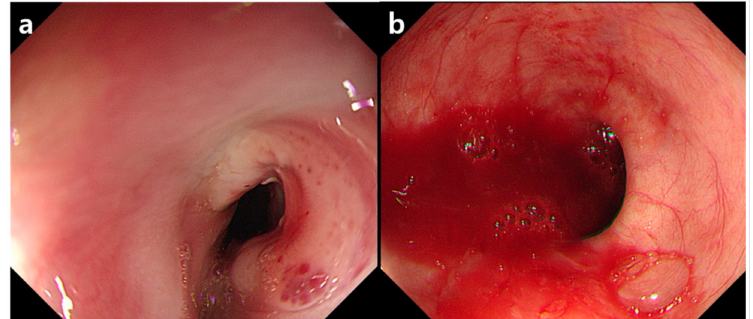
Figure 3. ( a ) Endoscopy on the first day showing a mass like lesion with an ulcer and red pigmen- tation in the upper esophagus. Active bleeding focus was not found. ( b ) After two days, massive blood pumping was seen in the ulcer base. A pulsating vessel was also noted (not shown here). Two days later, the patient revisited our hospital because he could not get hemodialysis due to hypotension (systolic pressure, 60 mmHg) and decreased thrill on the arteriove- nous fistula. Laboratory data demonstrated a drop in hemoglobin values (5.1 g/dL) and leukocytosis (white blood cell count: 12 × 10 3 / µ L). On upper GI endoscopy, an actively bleeding and pulsating vessel was seen in the previous esophageal ulcer base (Figure 3b). The pathology specimen obtained from the esophagus two days before did not show any evidence of malignancy.